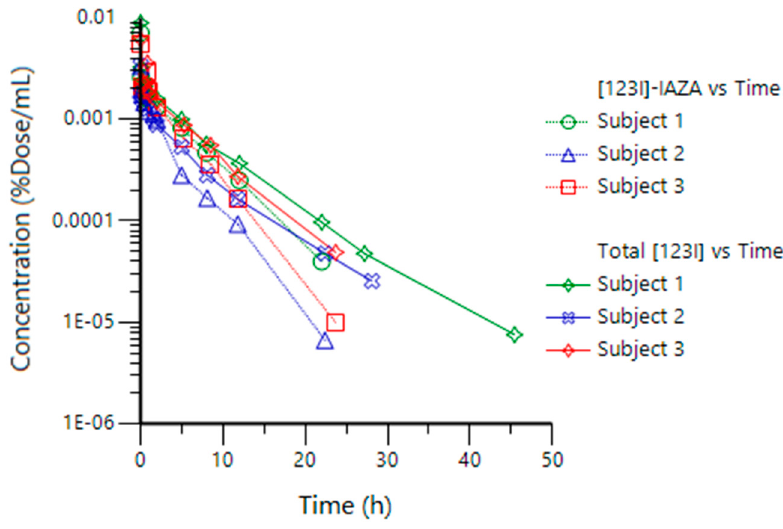
Figure 2. Concentration-time plots for [ 123 I]IAZA and total[ 123 I] in each subject.